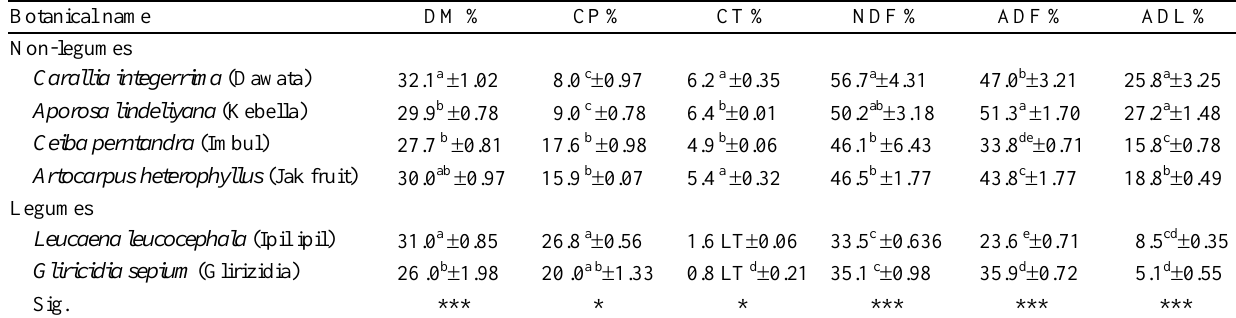
Table 3. Proximate composition of